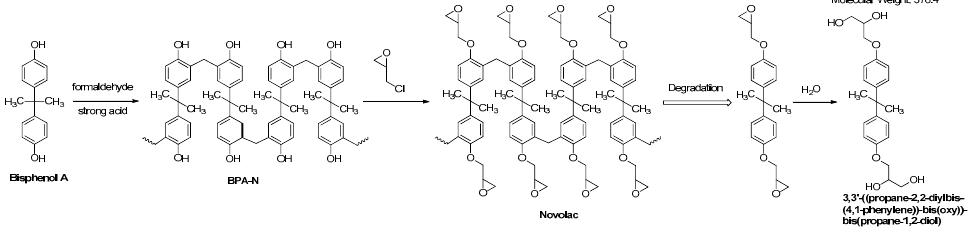
Figure 11. Proposed formation of a novolac resin from bisphenol A and its degradation to 3,3 ′ -((propane-2,2-diylbis(4,1-phenylene))bis(oxy))bis(propane-1,2-diol), which is promoted by bacteria.